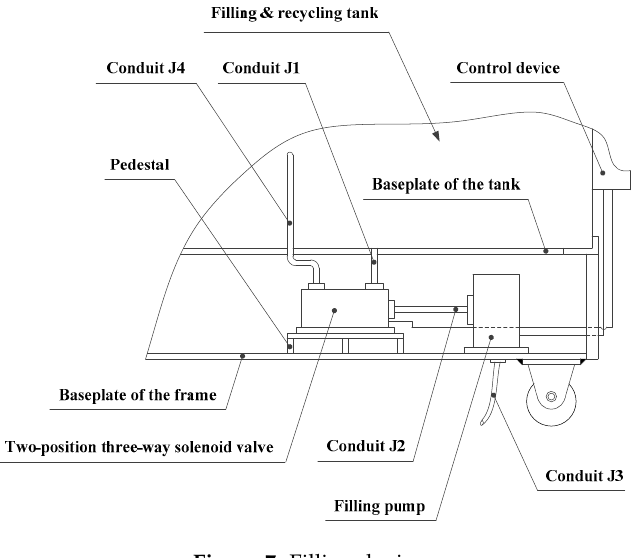
Figure 7. Filling device.